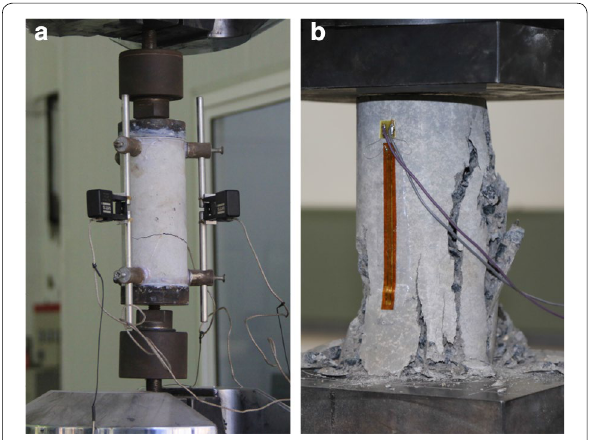
Fig. 9 Typical failure patterns of the laboratory tests. a Typical failure pattern under tension, b typical failure pattern under